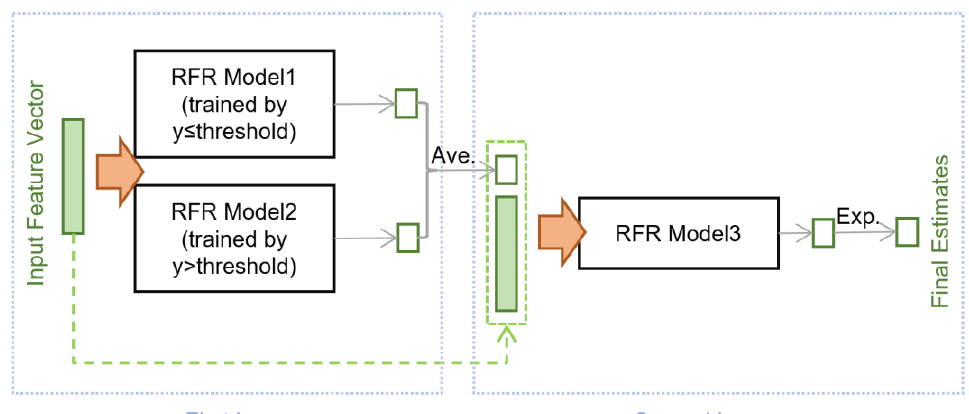
Figure 3. The two-layer stacked random forest model.